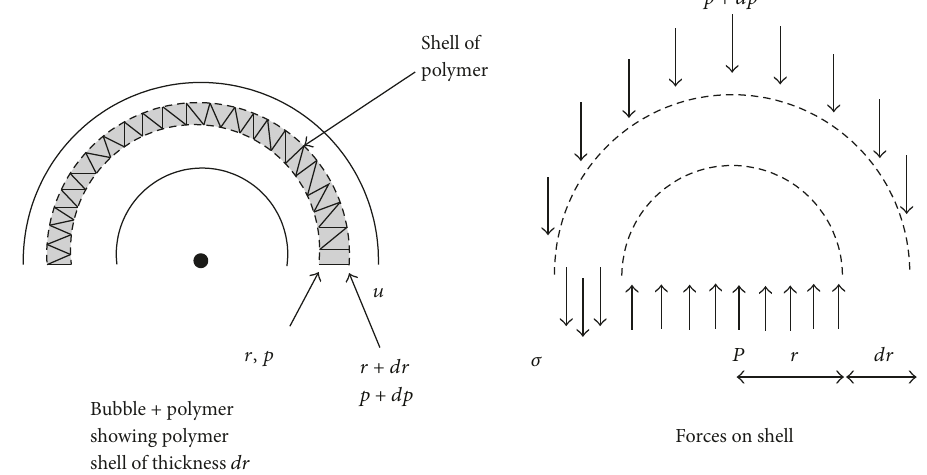
Figure 13: Force balance